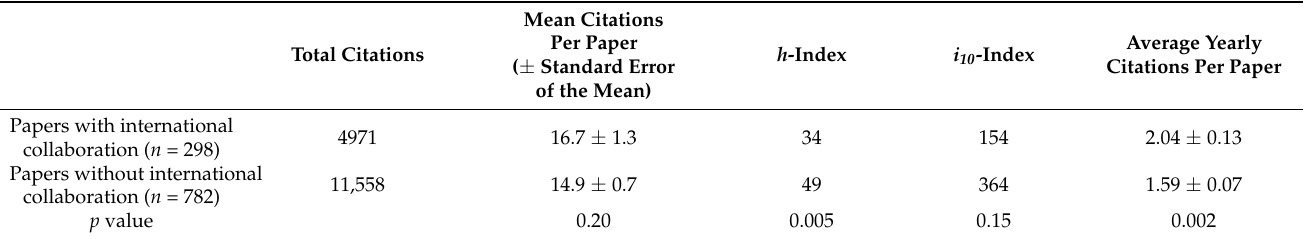
Table 4. Measures of impact of papers on sheep and goats published during 1997–2022 from Greece, according to involvement of international collaboration.